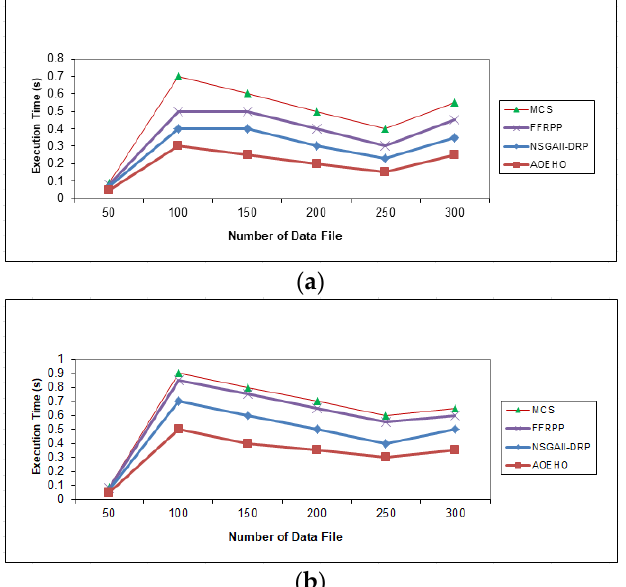
Figure 7. Execution time of data file. ( a ) Size of data replication = 64 MB. ( b ) Size of data replication = 320 MB.